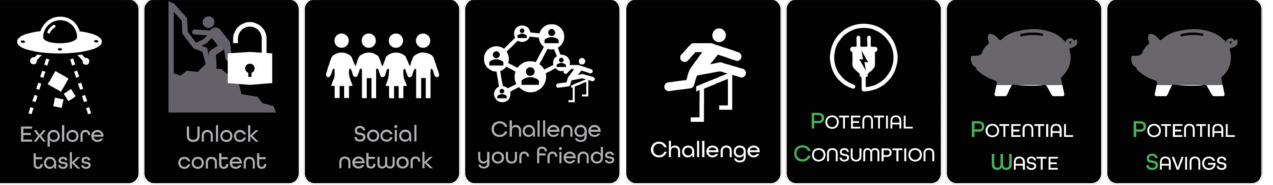
Figure 6. These gamified elements change depending on the decision